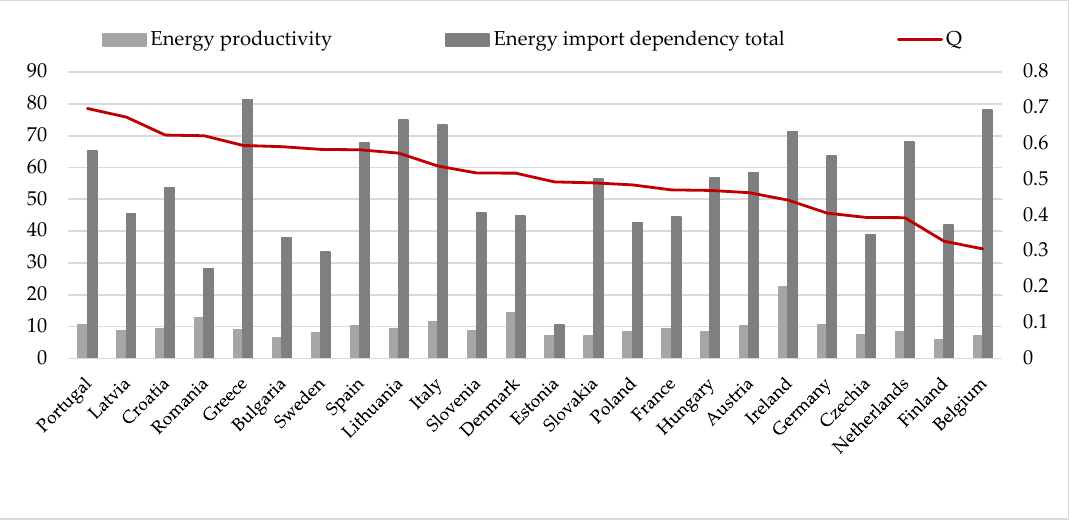
Figure 6. Sustainable energy consumption ( Q , determined by Formula (3)), energy productivity, and total energy import dependency in 2020. Table 6. Correlations between selected indicators in